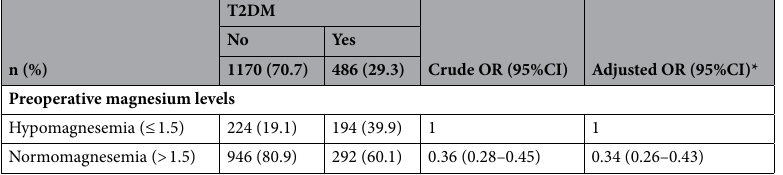
Table 3. Association between serum magnesium levels and T2DM. * Adjusted for sex, age and body mass index.